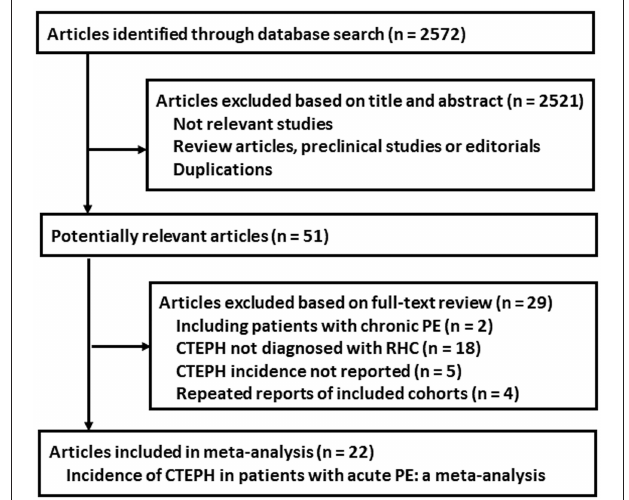
FIGURE 1 | Flowchart of literature